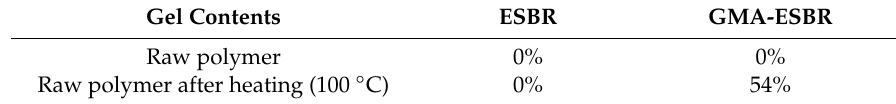
Table 5. Gel contents after thermal treatment (5 min, at 100 °C).